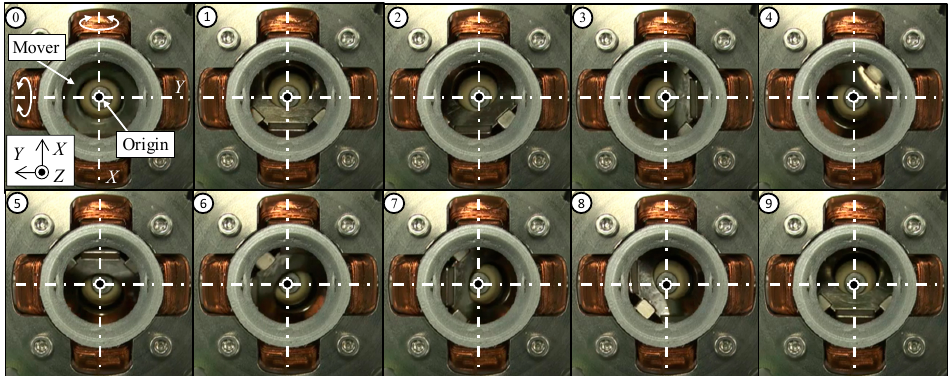
Figure 9. Operating verification of the single-axis drive ( X -axis).